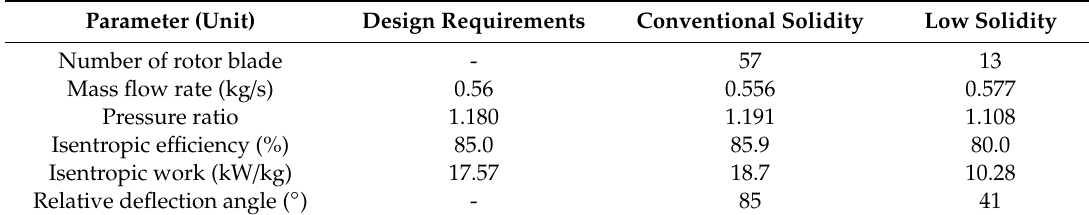
Table 3. CFD results of the performances of the conventionally designed tip turbines.